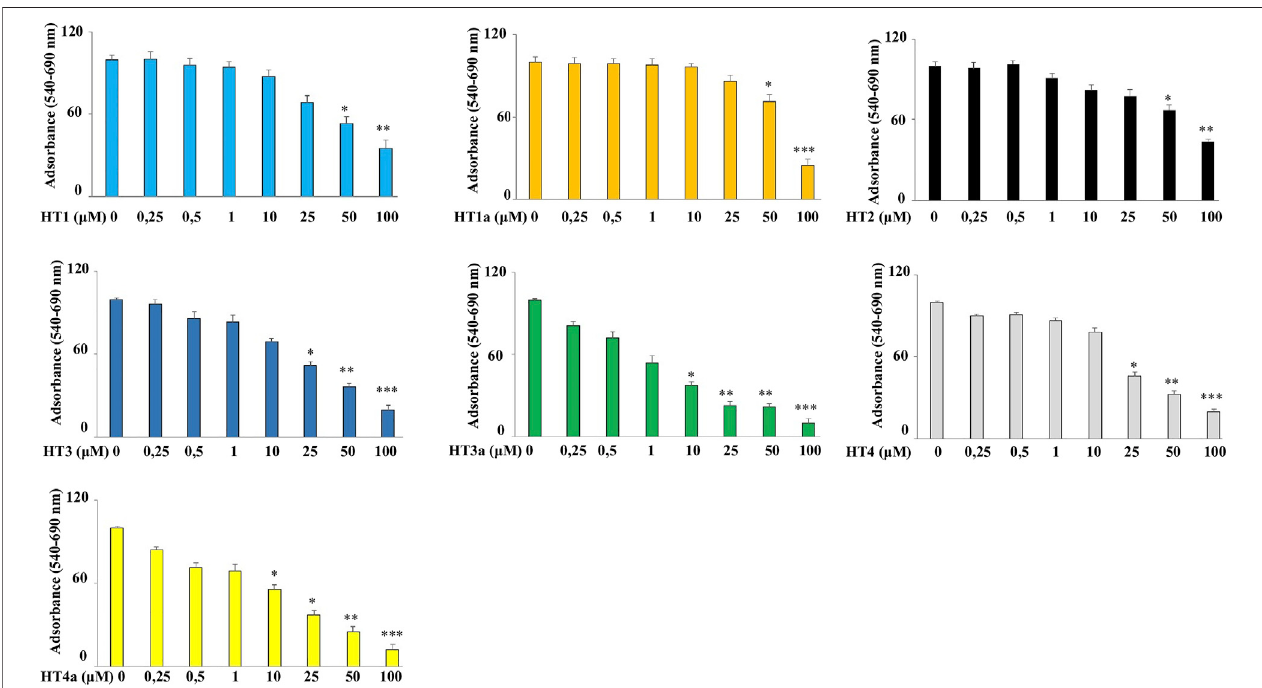
FIGURE 4 | Effects of donepezil hybrids on cell viability in human neuroblastoma cells. Human neuroblastoma (SH-SY5Y) cell line was treated with donepezil hybridsfor24 hattheconcentrationsshowninthe fi gure.ThecellviabilitywasmeasuredthroughtheMTTassay.Therateofviabilityofuntreatedcellswassetat100and all other values were related to it. Three independent experiments were carried out, with values expressed as the mean ± standard deviation. * p < 0.05 vs. control; ** p < 0.01 vs. control; *** p < 0.001 vs. control. Analysis of Variance (ANOVA) was followed by a Tukey – Kramer comparison test.